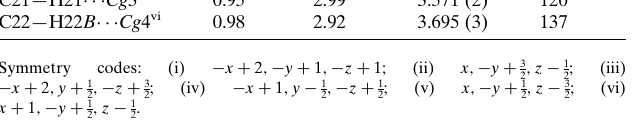
Figure 1 The title molecule, showing the atom-numbering scheme, with displace- ment ellipsoids drawn at the 50% probability